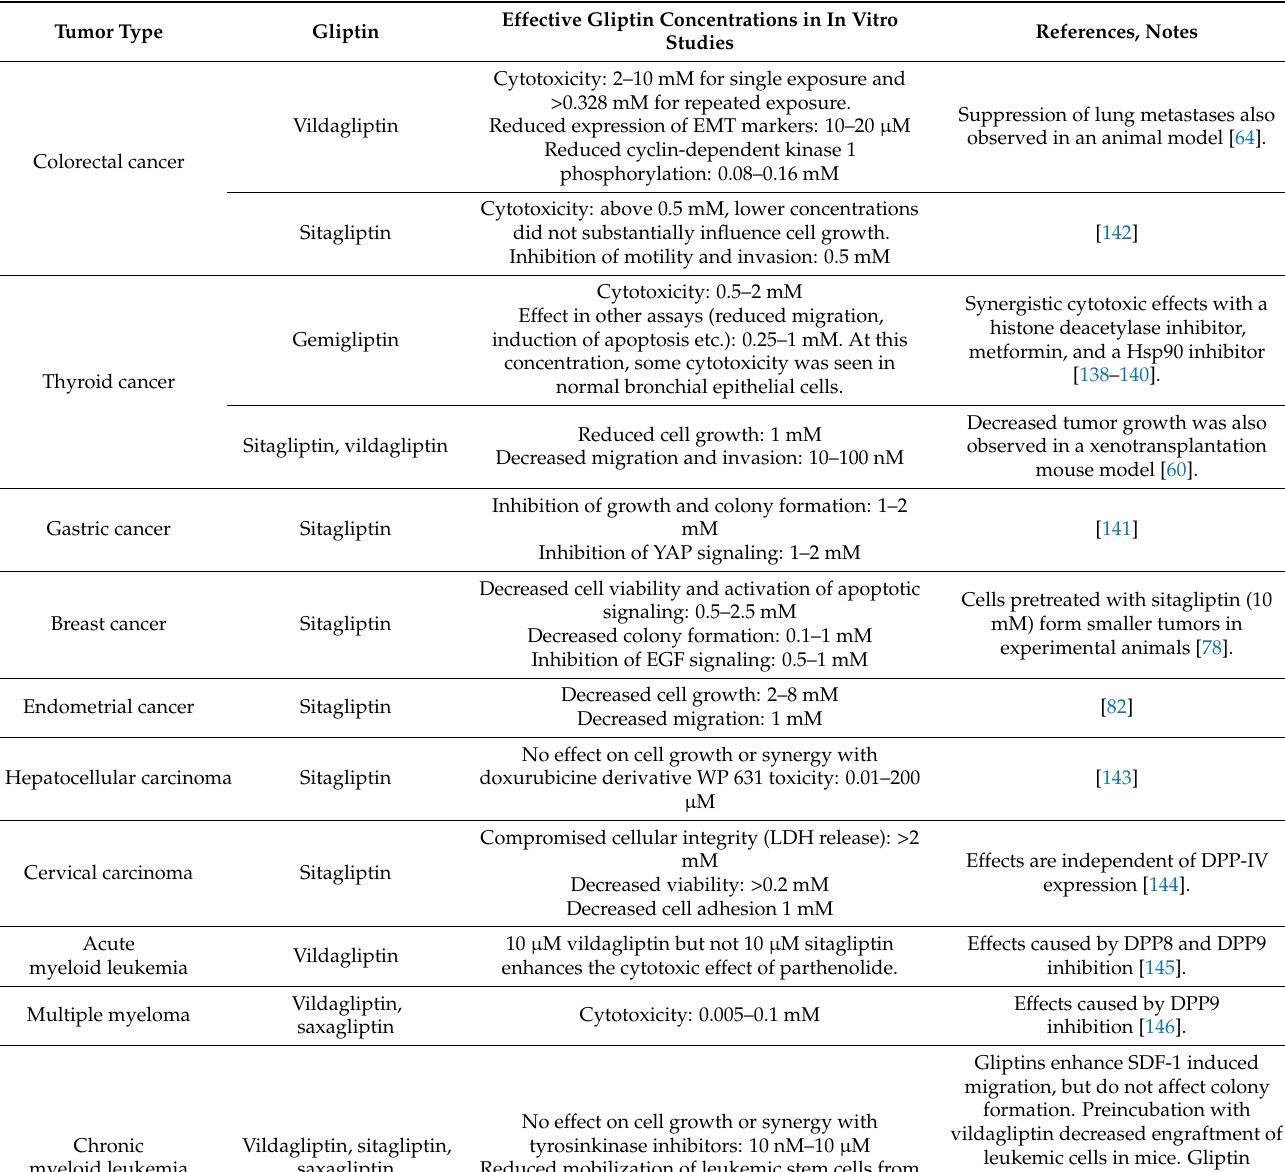
Table 4. Summary of studies evaluating direct cytotoxic effects of